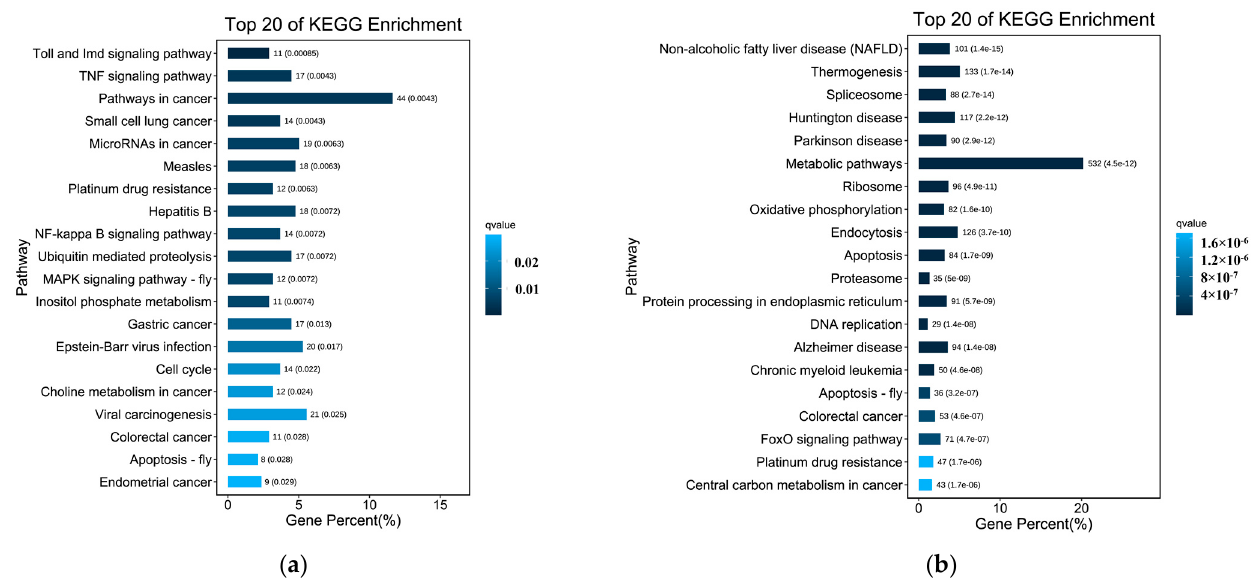
Figure 7. KEGG enrichment bar chart. ( a ) KEGG enrichment bar chart for siRNA − MSTRG.16919.1 and siRNA − MSTRG.16919.1 NC ; ( b ) KEGG enrichment bar chart for siRNA − MSTRG.16919.1 and BHV − 33 h. The ordinate is path and the abscissa is the percentage of the number of pathways to the number of all differential genes. The darker the color is, the smaller the Q value is. The values on the column are the number of pathways and Q value.